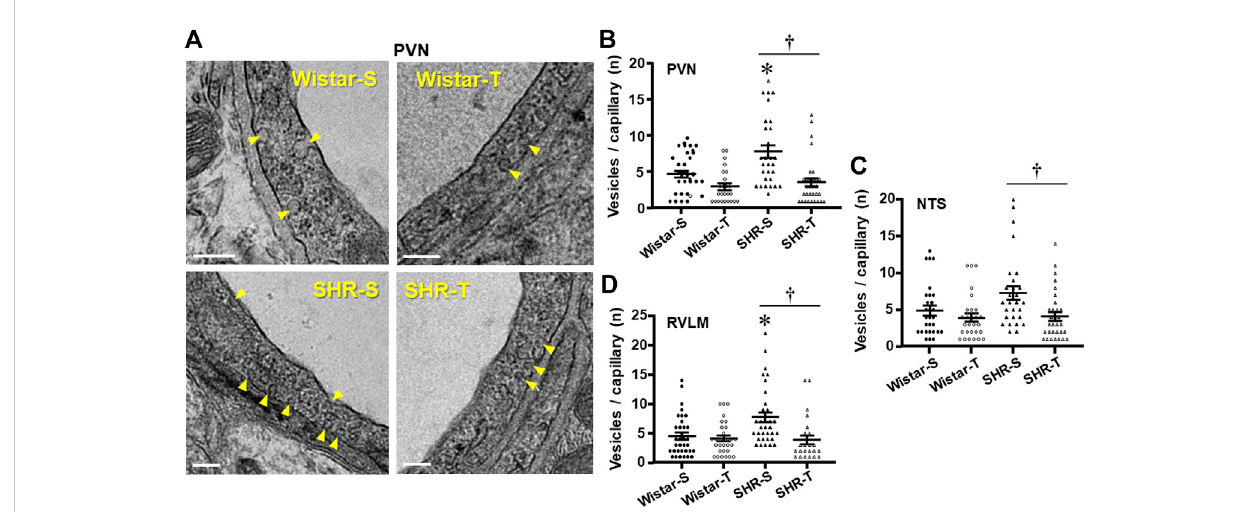
FIGURE 2 Effectsofhypertensionandexercisetrainingontranscellularvesiclesnumber/capillary. (A) .Electronmicrographsdepictingthetranscellularvesicles (yellow arrows) being formed in the luminal and abluminal borders of the endothelial cell within PVN capillaries of sedentary (S) and trained (T) SHR and Wistar rats. Scale bars = 200 nm Right panels show the quanti fi cation of vesicle number in the 4 experimental groups at the end of protocols within the PVN (B) , NTS (C) , and RVLM (D) capillaries. n = 9 – 11 capillaries/rat, 3 rats/group. Comparisons made by 2-way factorial ANOVA. Signi fi cances ( p < 0.05) are * vs. respective Wistar group; † vs. respective S control.